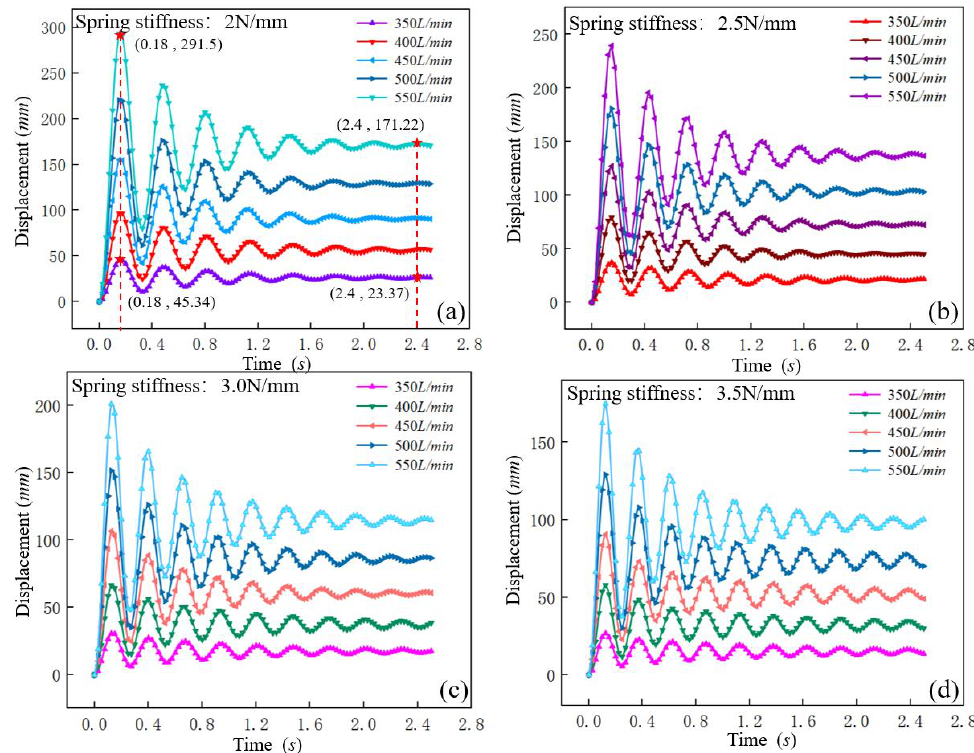
Figure 5. The sliding core movement displacement changes with spring stiffness and drilling fluid flow: ( a ) Spring stiffness 2 N/mm; ( b ) Spring stiffness 2.5 N/mm; ( c ) Spring stiffness 3.0 N/mm; ( d ) Spring stiffness 3.5 N/mm.